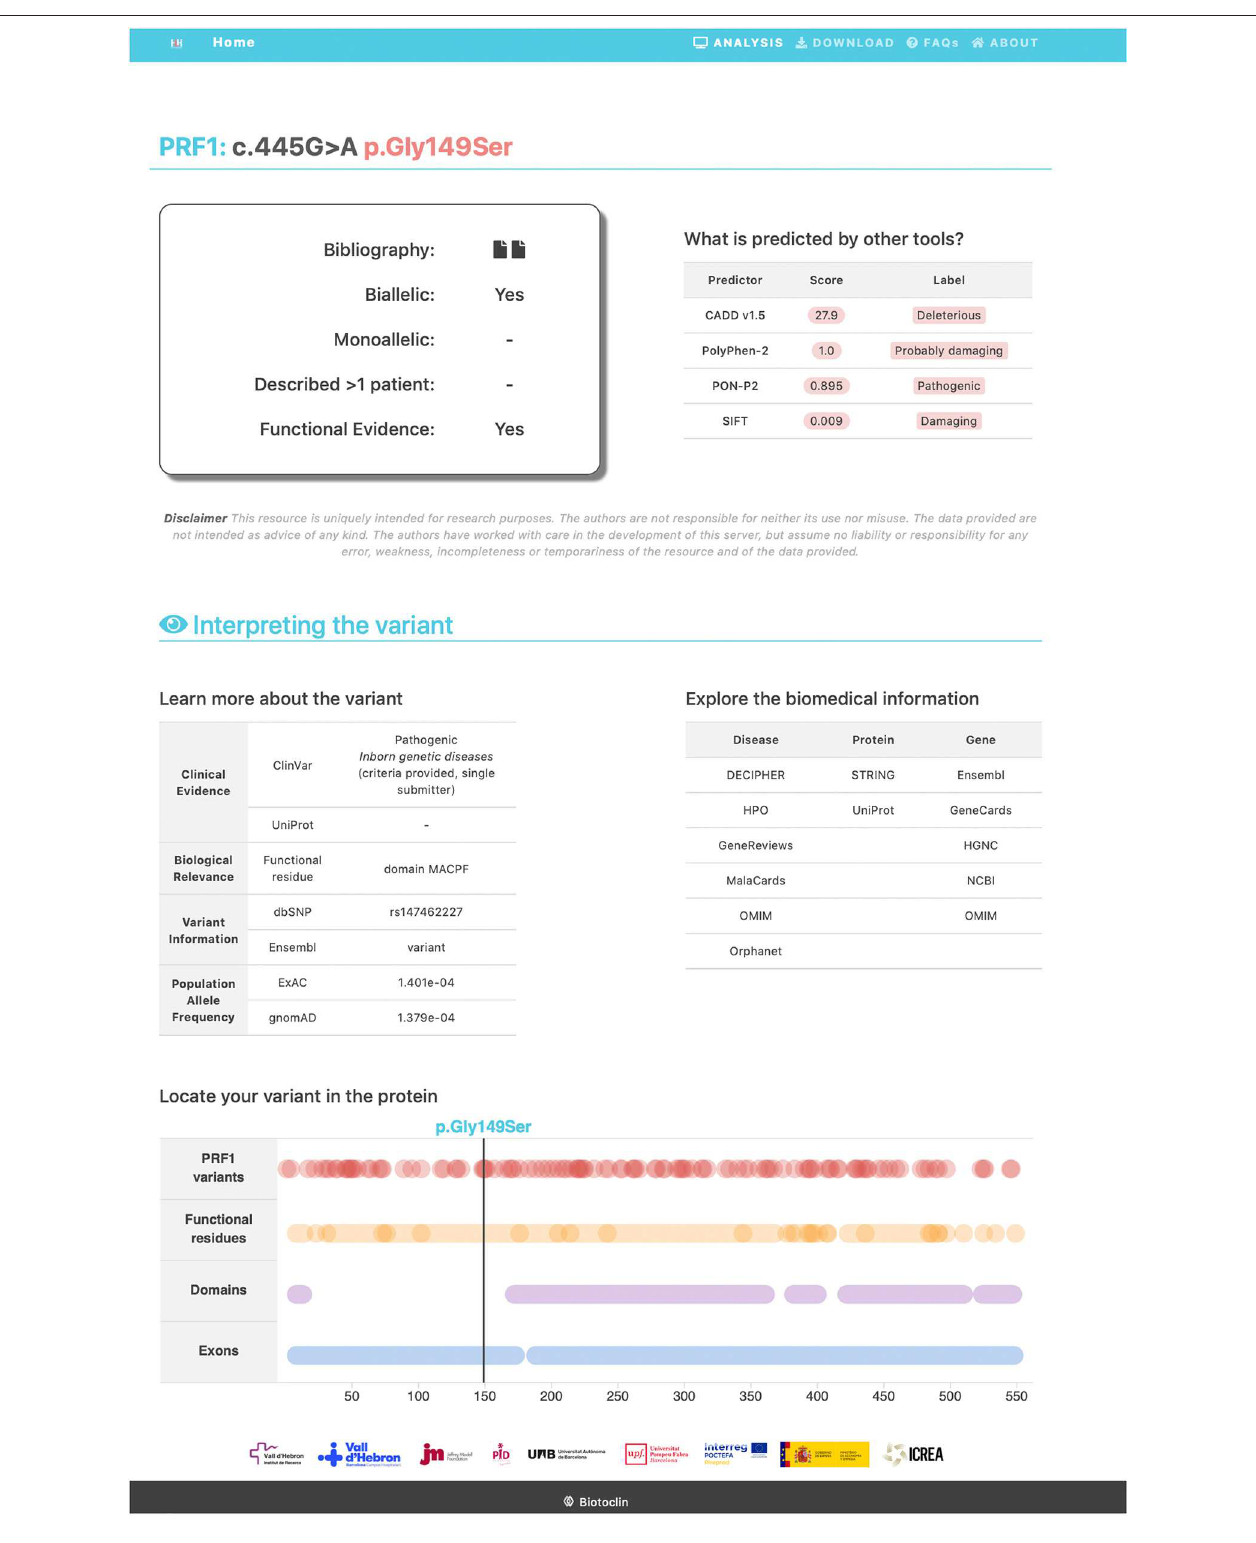
FIGURE 5 | Example of the detailed information page, containing specific information about a variant. A missense variant in the PRF1 gene is shown.